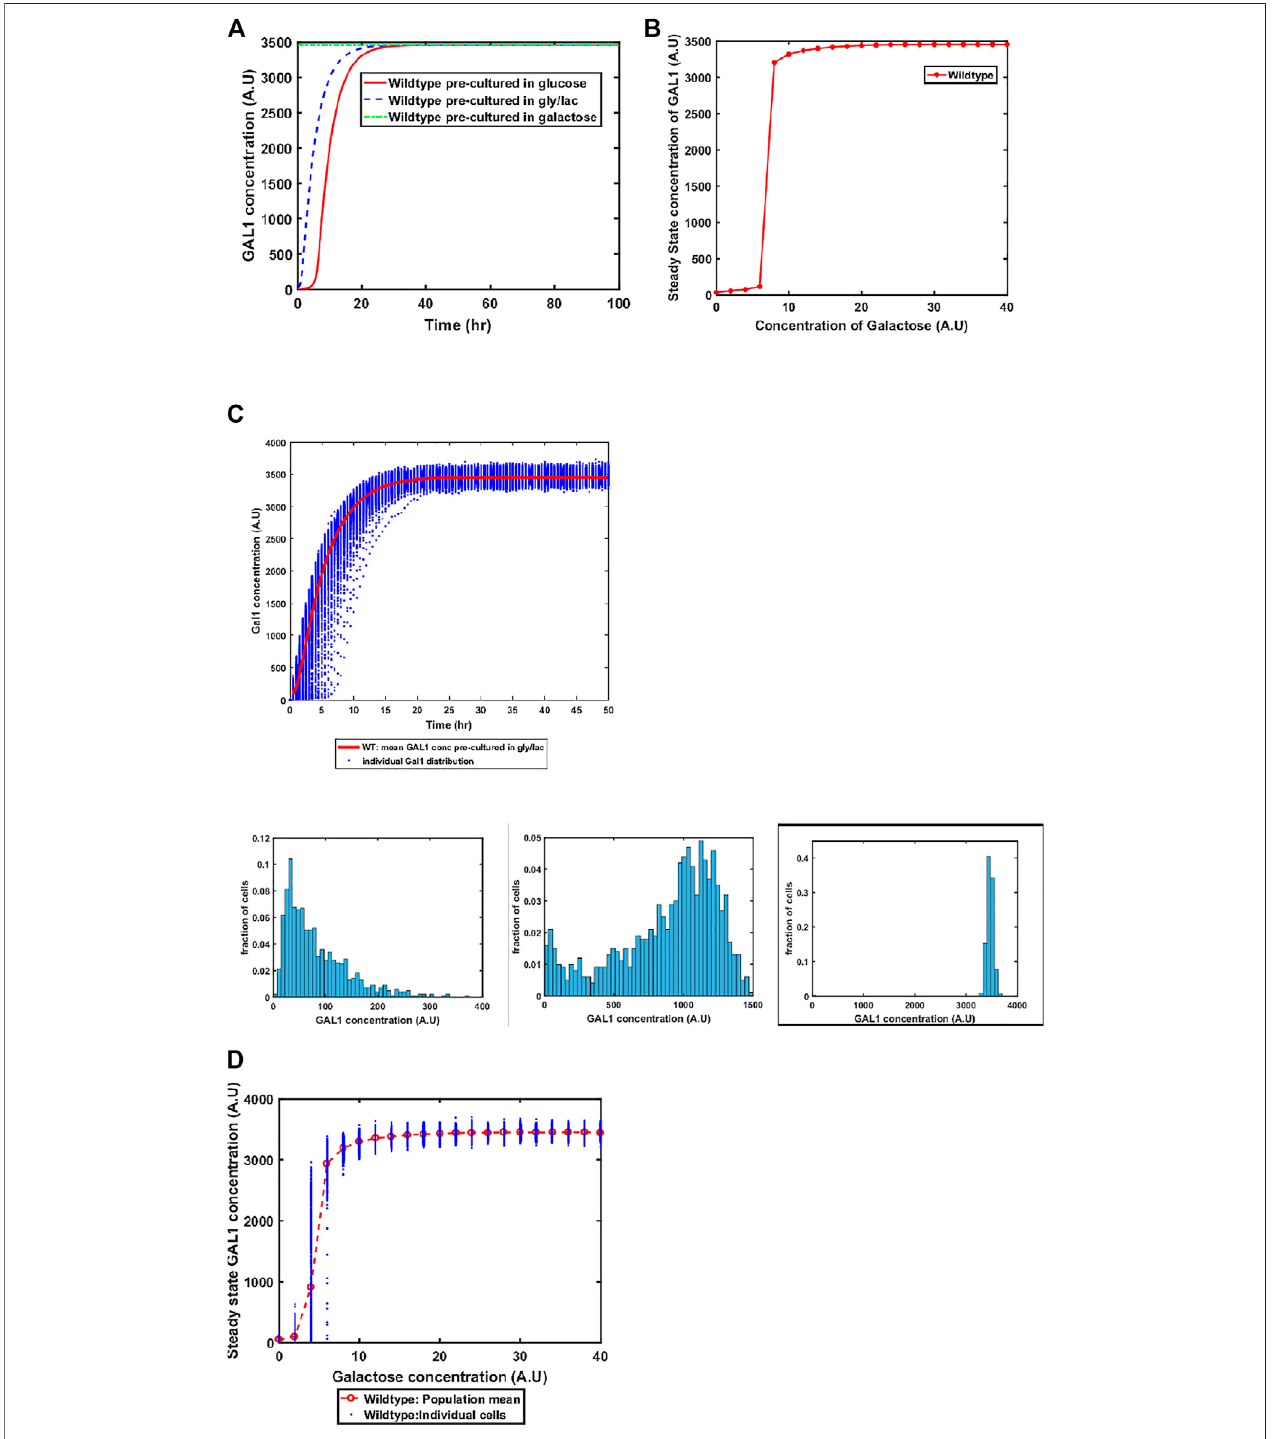
FIGURE3|(A) ActivationofGALnetworkingalactose[concentration,30(A.U)].GAL1pro fi leofwildtypepre-culturedingly/lac(dashedblueline),glucose(solidred line), and galactose (dashed green line). (B) Steady state concentration of GAL1 protein at different concentrations of galactose in wild type S. cerevisiae . Note that the system exhibits athreshold-like activation. (C) Dynamic GAL1 responseat galactoseconcentration of 30 (A.U) for 1000 wild-type cells pre-grown in gly/lac. Histograms of GAL1 expression at 30 min, 5 h, and 50 h. (D) Steady state concentration of GAL1 under different concentration of galactose for wild type.